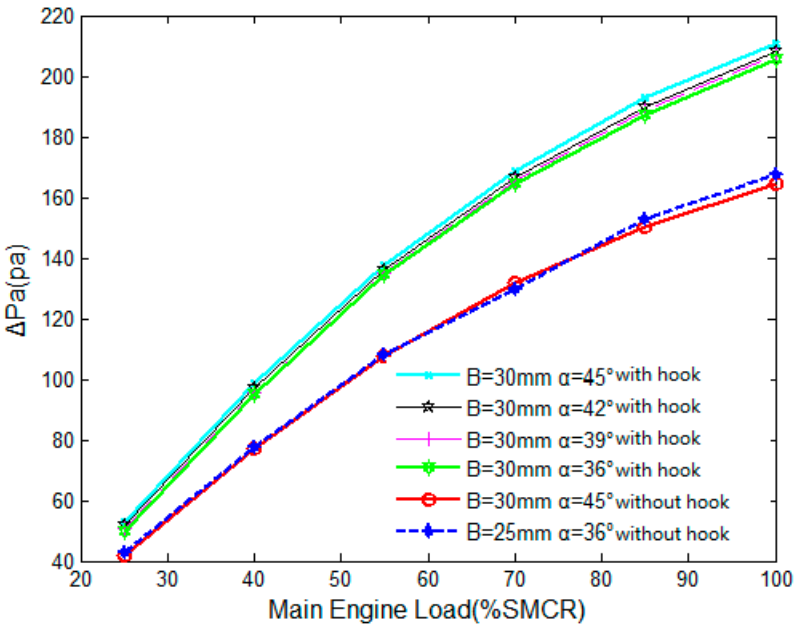
Figure 8. Influence of corrugated plate turning angle on the total pressure loss.